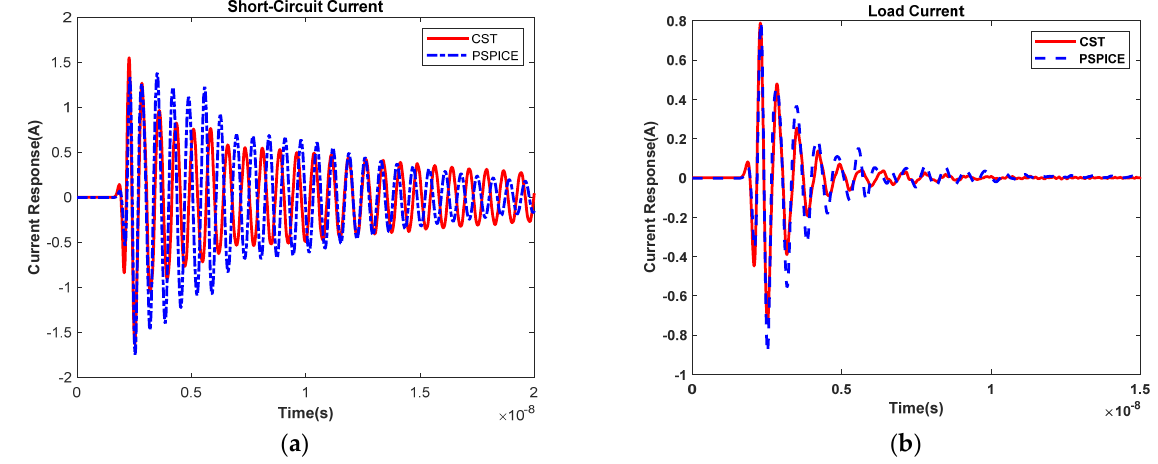
Figure 11. Validation of Thevenin SPICE model: ( a ) SC current; ( b ) Load current.